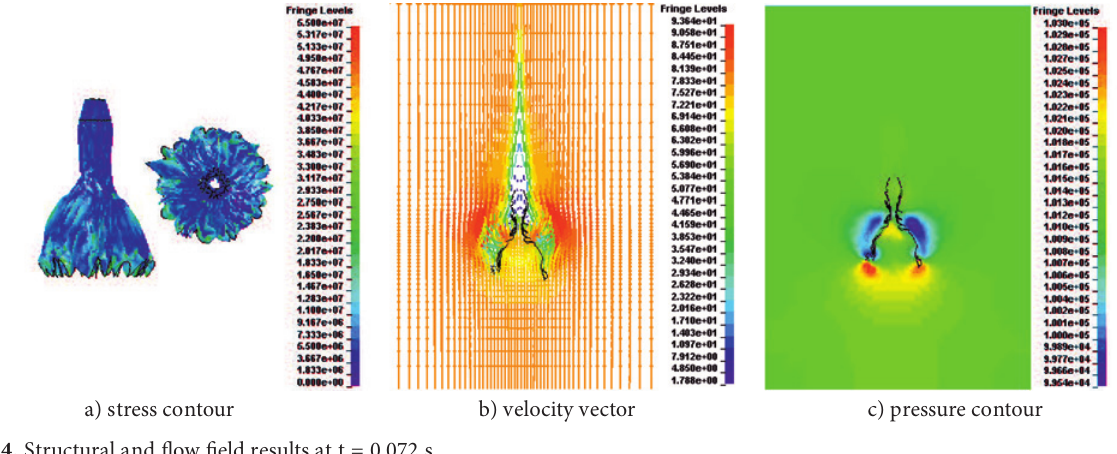
Fig. 4. Structural an d flow fie ld results a t t = 0.072 s